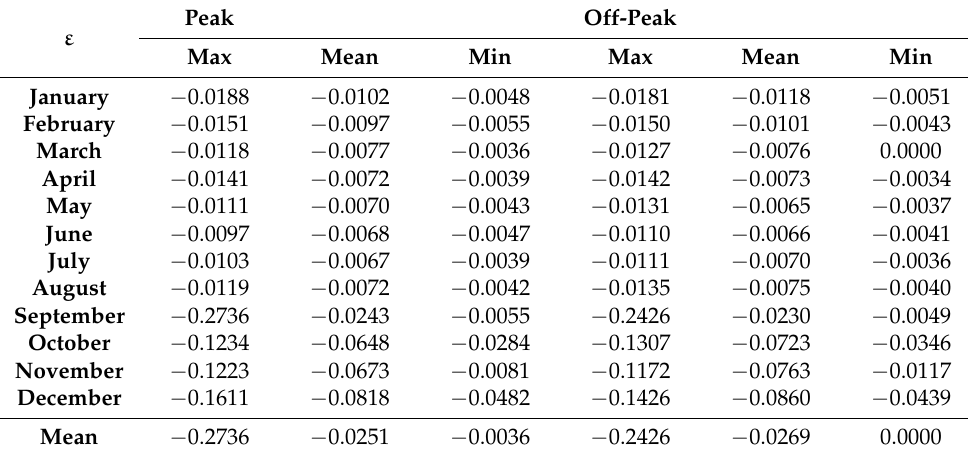
Table A1. Summary Statistics of the Elasticity Estimates Aggregated by Month-Peak and Off- Peak Hours. Peak Off-Peak ε